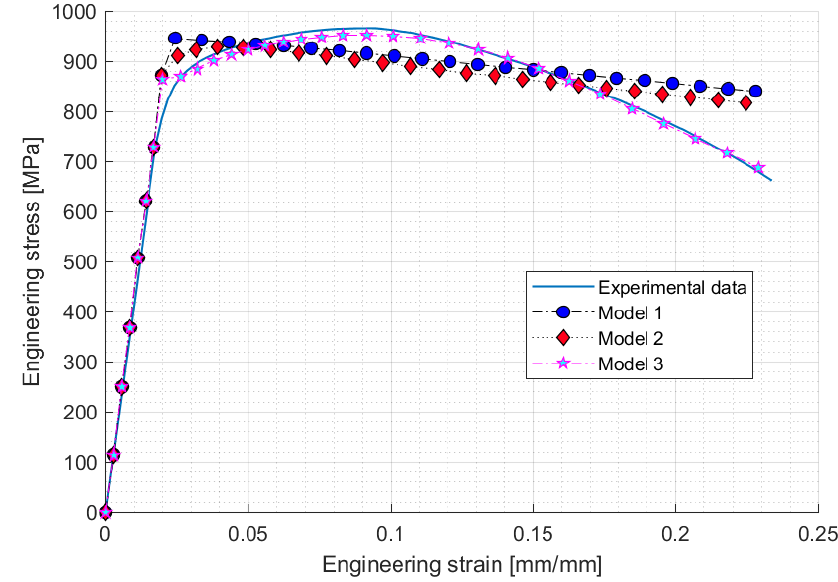
Figure 13. Inverse method results for the proposed method.